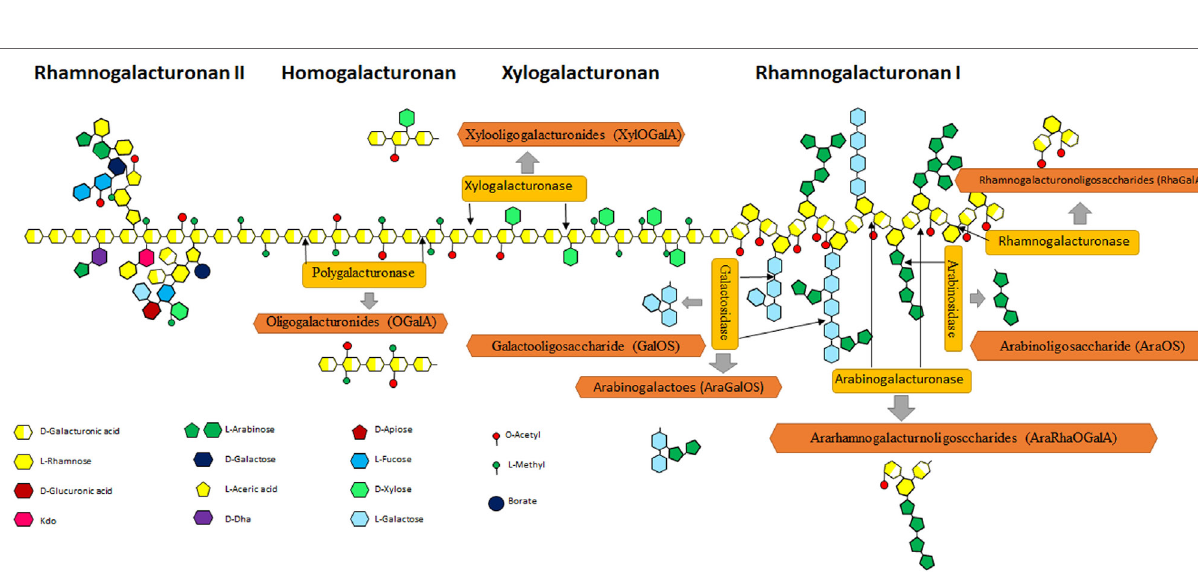
FiguRe 3 | Schematic representation of pectin structure. Pectin consists of rhamnogalacturonan I (RG-I), homogalacturonan (HG), xylogalacturonan, and rhamnogalacturonan II regions. HG is a linear polymer consisting of a chain with an estimated length of 72–100 GalA units that represent, approximately, 60% of the total pectin (41). Xylogalacturonan is a chain of GalA residues partially substituted by d -xylose residues connected by β -(1,3) links at C-3 and/ or C-2 positions. RG-I represents up to 7–14% of pectin and contains alternating units of α -(1,4)-galacturonosyl and α -(1,2)-rhamnosyl (42). In many cases, rhamnose residues show side chains as substituents on the O-4 position, made up of arabinan and/or arabinogalactan I and II, although xylose or glucose modification also exists (43). Rhamnogalacturonan II (RG-II) is a region characterized by a length of 7–9 GalA units, where complex branches made up of 12 types of monosaccharides (as a maximum) can exist, including some minority monomers such as apiose, fucose, acetic acid, DHA, or KDO (44).